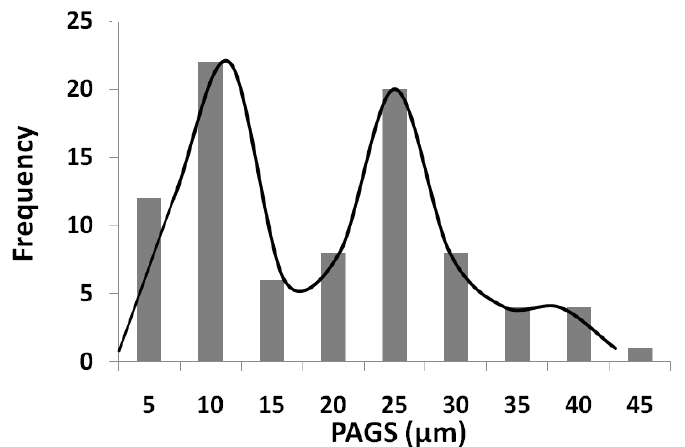
Figure 6. Prior austenite grain size (PAGS) distribution.